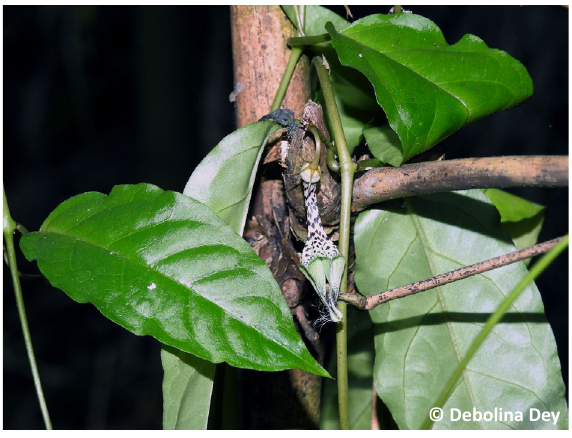
Image 1. Habit of Ceropegia lucida Wall. Image 2. Inflorescence with leaves of Ceropegia lucida Wall.